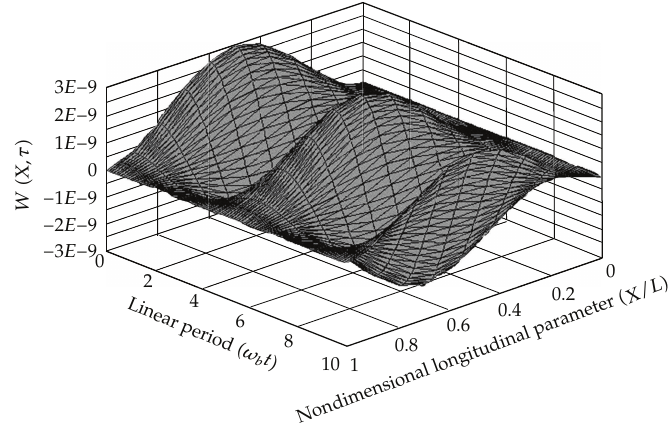
Figure 9: Amplitude-time-space diagram of a C-C SWNT (cid:3) k (cid:8) 10 7 N/m 2 and X (cid:8) 2 (cid:4)